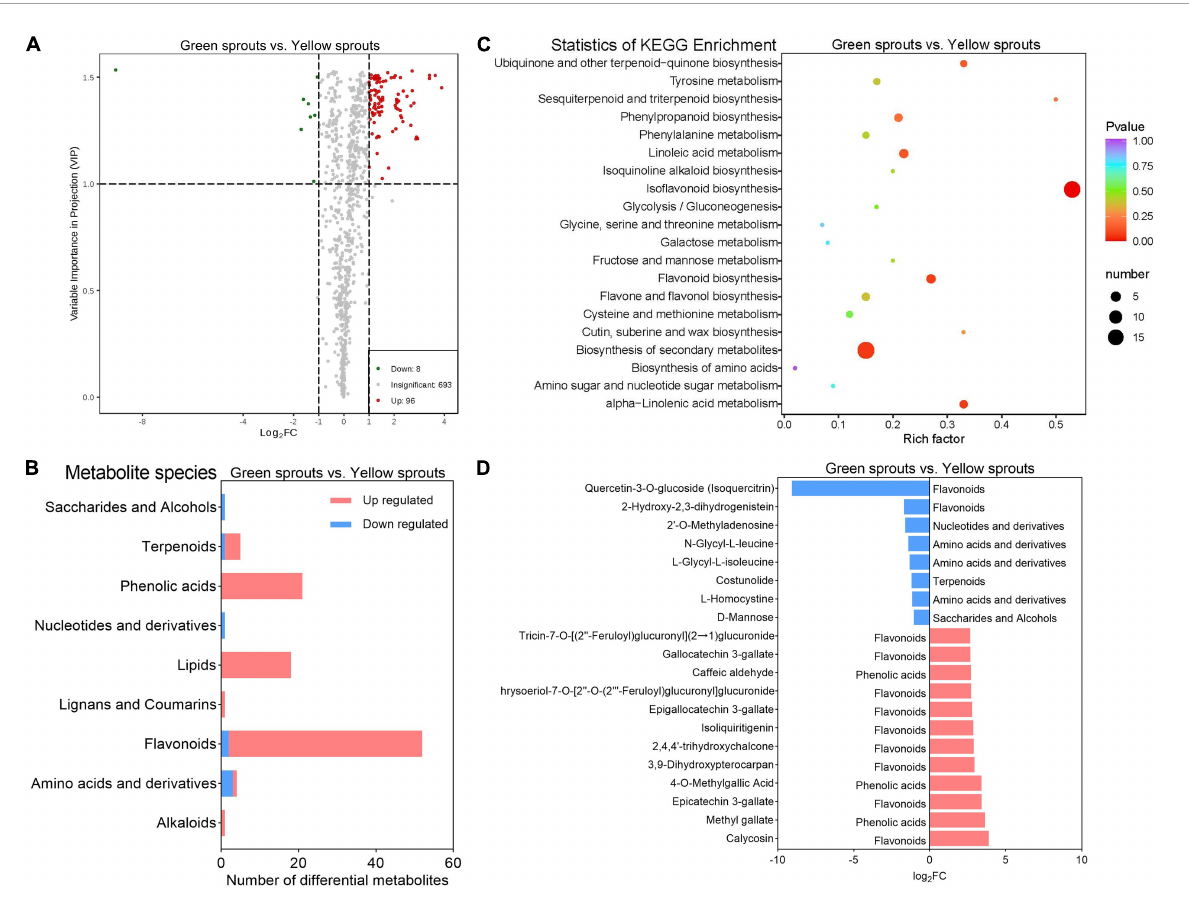
FIGURE3 Metabolomic analysis of alfalfa sprouts. (A) DAM volcano map of green vs. yellow alfalfa sprouts. (B) The number of DAMs that were up- and downregulated in different classes between green and yellow alfalfa sprouts. (C) KEGG pathway enrichment of DAMs between green and yellow alfalfa sprouts. (D) The eight downregulated DAMs and the 12 most upregulated DAMs in green vs. yellow alfalfa